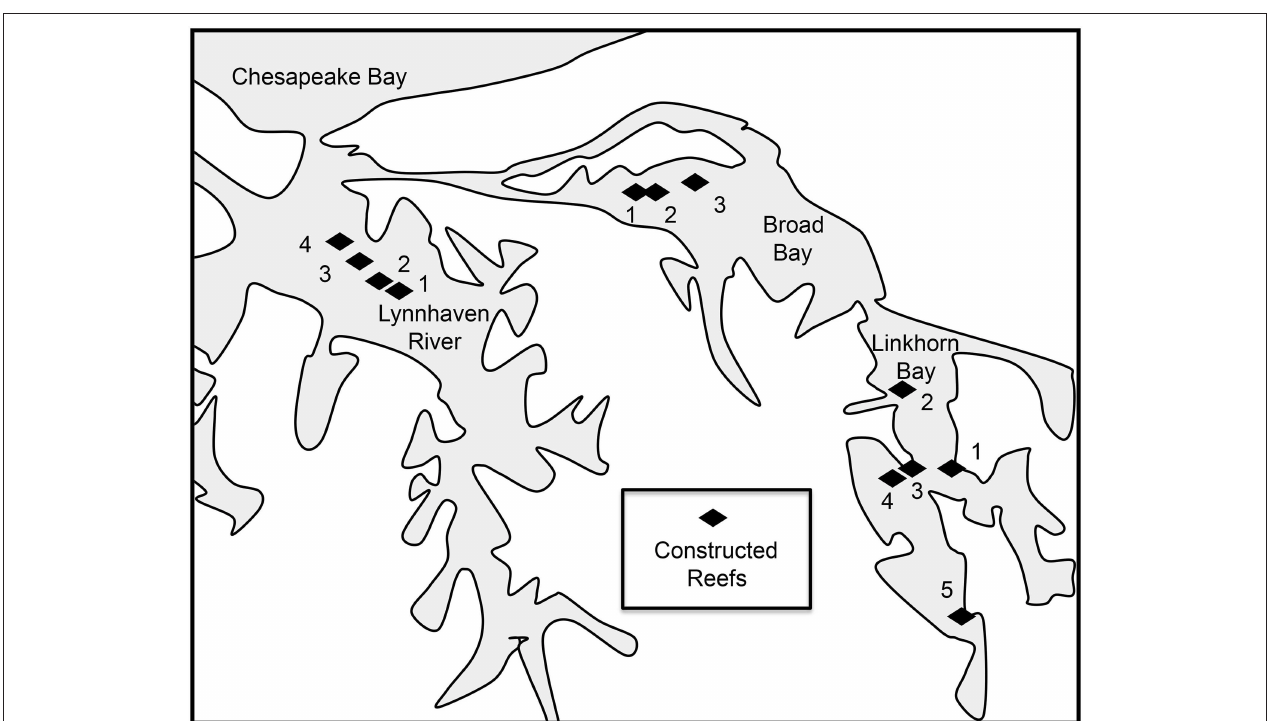
FIGURE 2 | Sites of sanctuary oyster reefs constructed in the Eastern Branch of the Lynnhaven River (LR1-4), Broad Bay (BB1-3), and Linkhorn Bay (LB1-5).